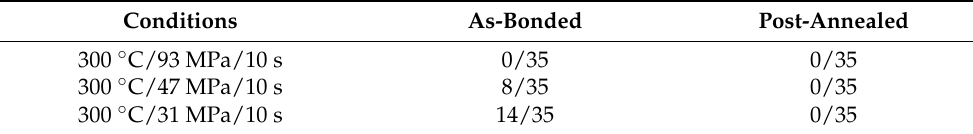
Table 1. Number of opened joints detected among 35 bumps measured by a 4-point-probe